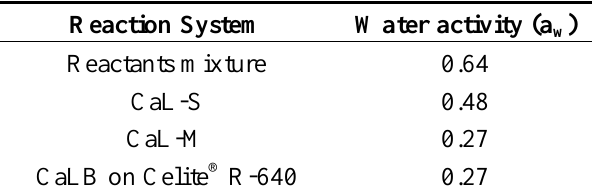
Table 2. Water activity of reaction systems in the presence of different preparations of immobilized CaLB.